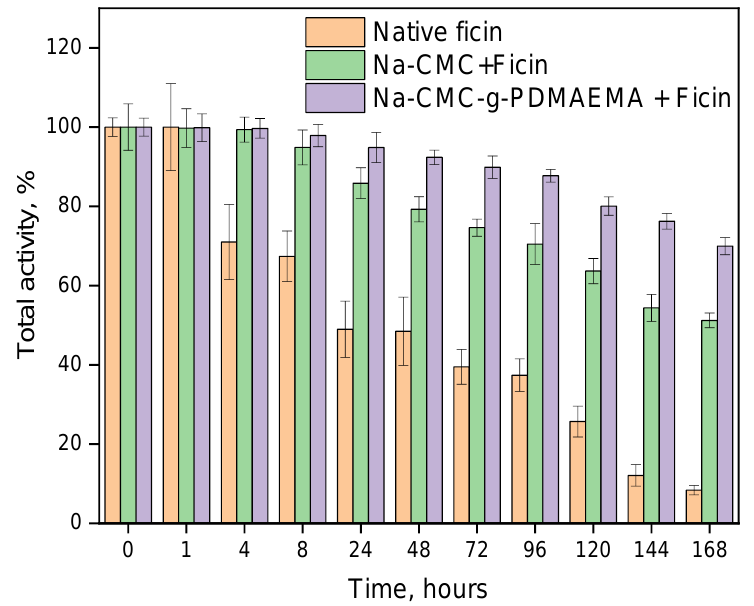
Figure 10. Storage stability of native and immobilized ficin.